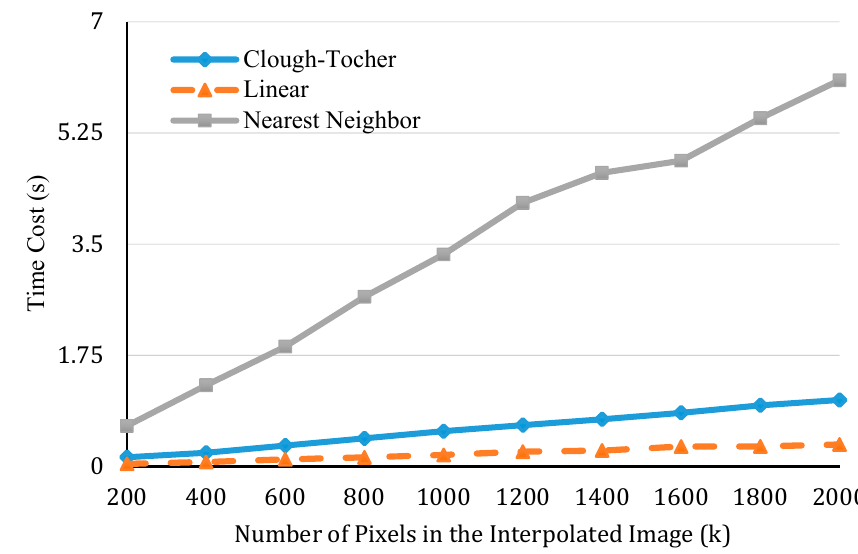
Figure 9. A comparison of efficiency by different interpolation methods, as the number of input points increases.